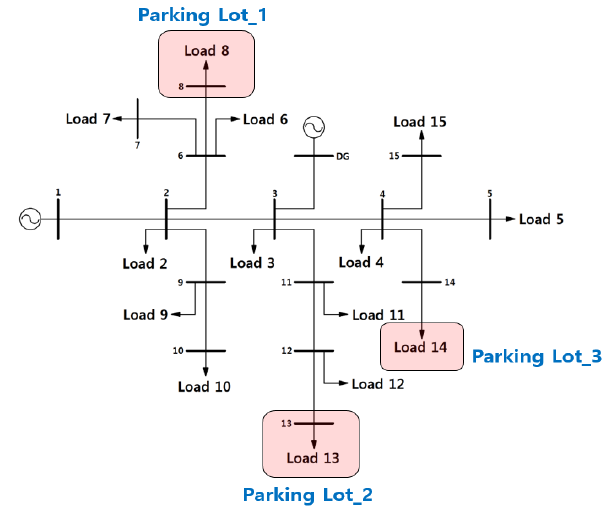
Figure 6. A schematic diagram of the IEEE 15 bus system with three EV parking lots.